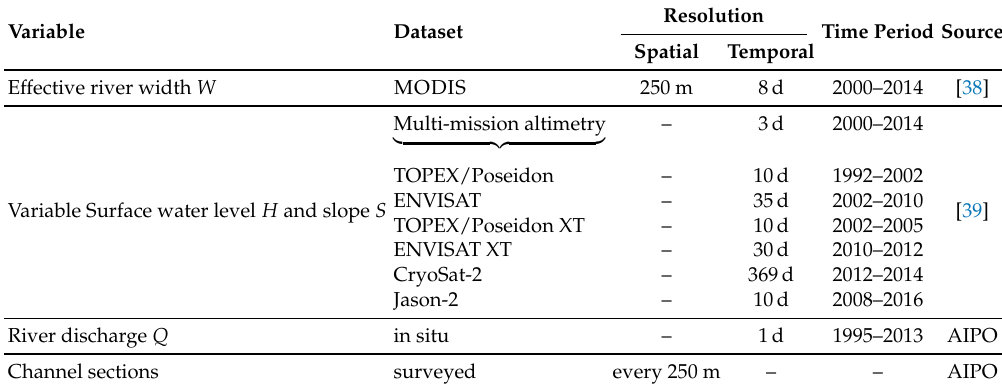
Table 2. Summary of the datasets used in this study. AIPO, Agenzia Interregionale Fiume